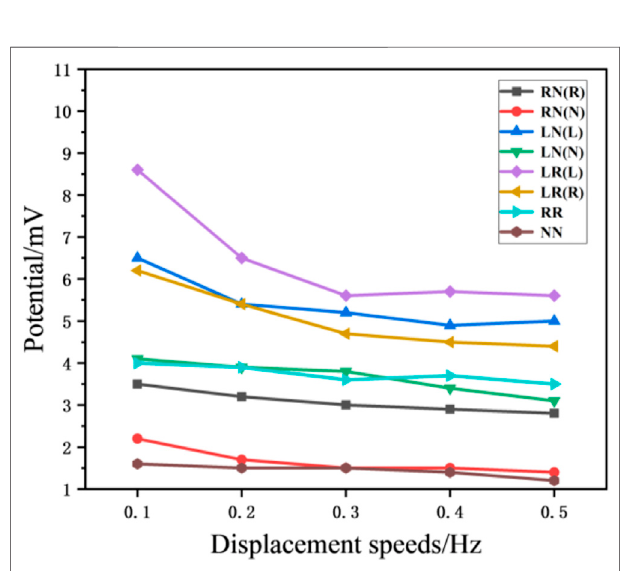
FIGURE 7 | The sensing voltage of the IPMC samples under displacement